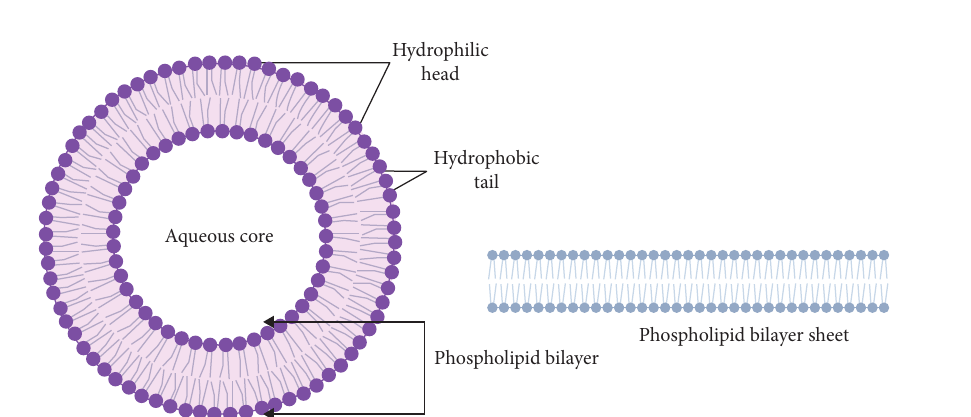
Figure 11: Structure of liposome and its phospholipid bilayer sheet.